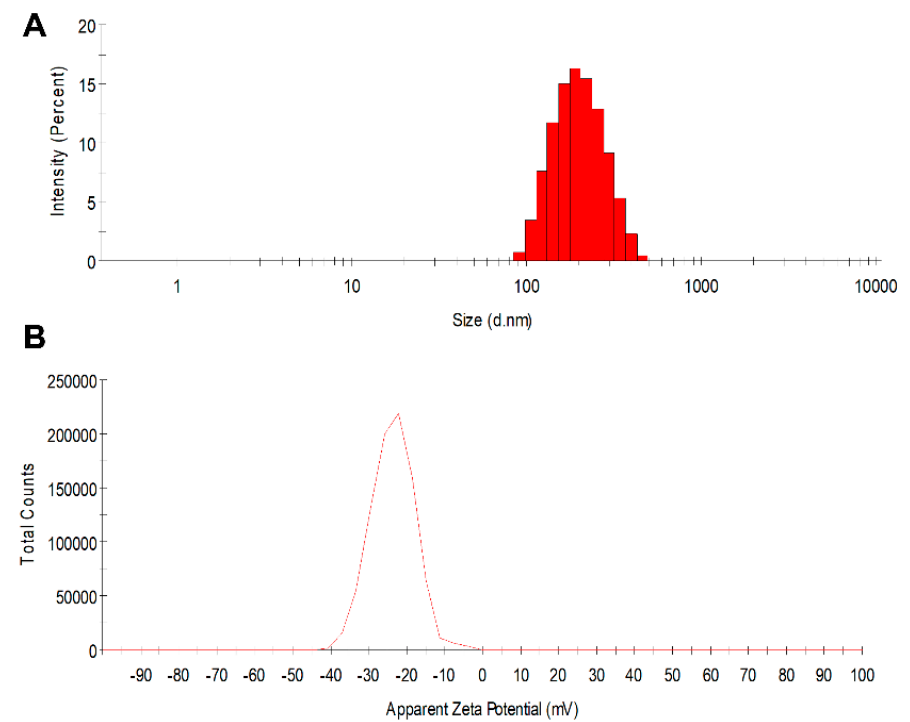
Figure 2. Characterization of PLGA nanoparticles loaded with GRFT and DPV. ( A ) Size and ( B ) zeta potential distribution graphs of nanoparticles encapsulated with anti-HIV drugs GRFT and DPV (NP-DPV/GRFT).